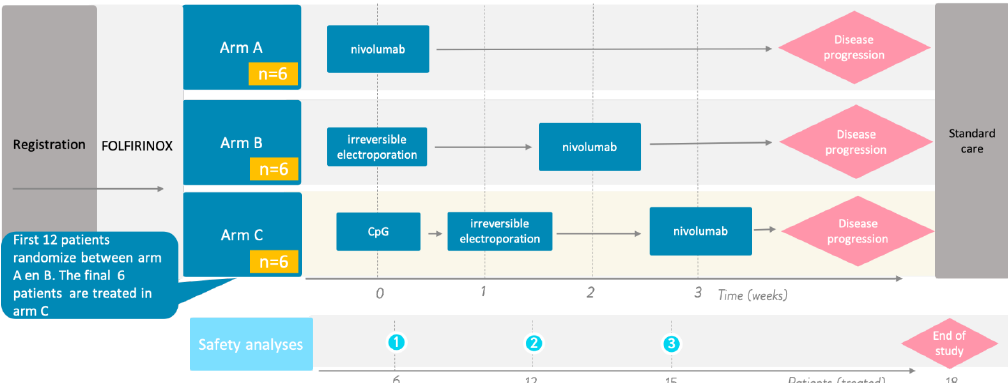
Figure 2. PANFIRE III treatment schedule. All patients require pretreatment with a minimum of 8 cycles of FOLFIRINOX, with at least stable disease, prior to PANFIRE III inclusion. The first 12 patients will be randomized to treatment arm A or B. Arm C will open for the last 6 patients upon the validation of the interim safety analyses. These safety analyses will be performed after the treatment of 6, 12, and 15 patients. Arm A: nivolumab monotherapy. Arm B: irreversible electroporation succeeded by intravenous administration of nivolumab. Arm C: priming with intratumoral injection of CpG (IMO-2125), followed by irreversible electroporation after 1 week. This is succeeded by intravenous administration of nivolumab two weeks later. In all treatment arms, nivolumab will be administered until unequivocal disease progression.